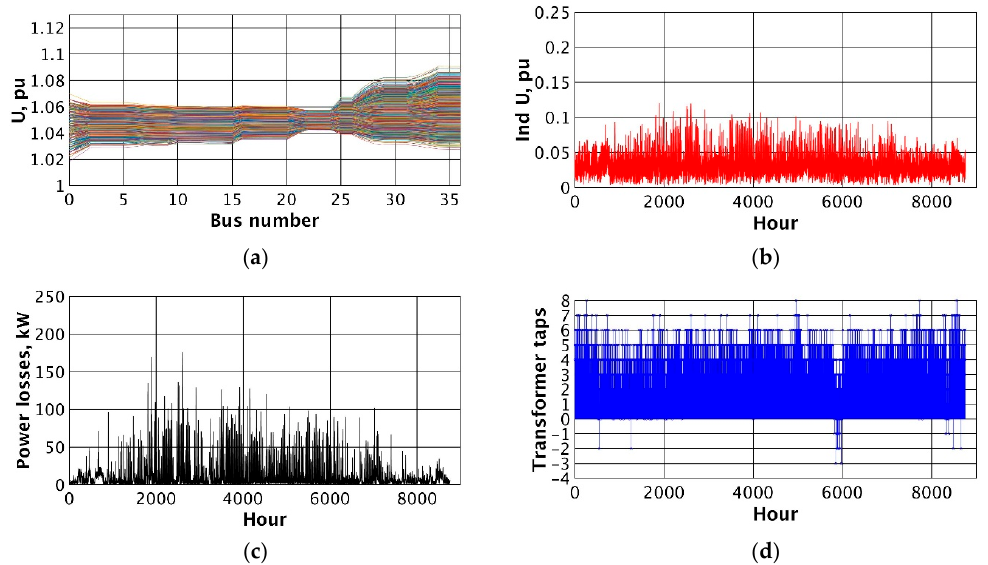
Figure 13. Graphs for data after optimisation ( a ) voltage values at all MV network nodes, ( b ) voltage indicator, ( c ) power losses, ( d ) transformer tap.